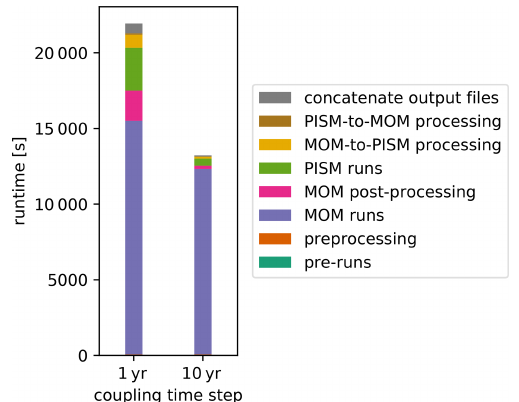
Figure 8. Runtimes of the coupled PISM–MOM5 set-up for 200 years of model time, using 32 cores and coupling time steps of 1 and 10 years. PISM runtimes include PICO, and MOM5 runtimes include SIS and FMS components. The elapsed time for individual components of the coupling framework is aggregated and stacked in the same order as in the legend. The runtimes are listed in Table